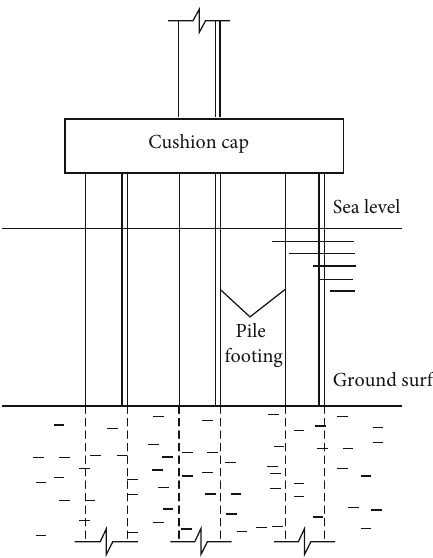
Figure 6: Structure diagram of a high-rise pile